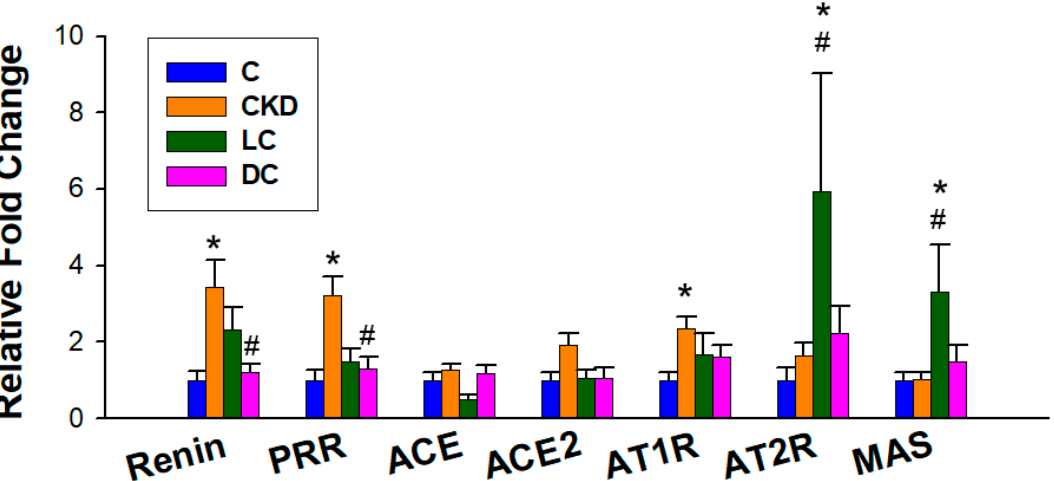
Figure 8. Effect of maternal chronic kidney disease (CKD), L -cysteine (LC), and D -cysteine (DC) on the renin–angiotensin system. n = 8/group. * p < 0.05 vs. C; # p < 0.05 vs. CKD.